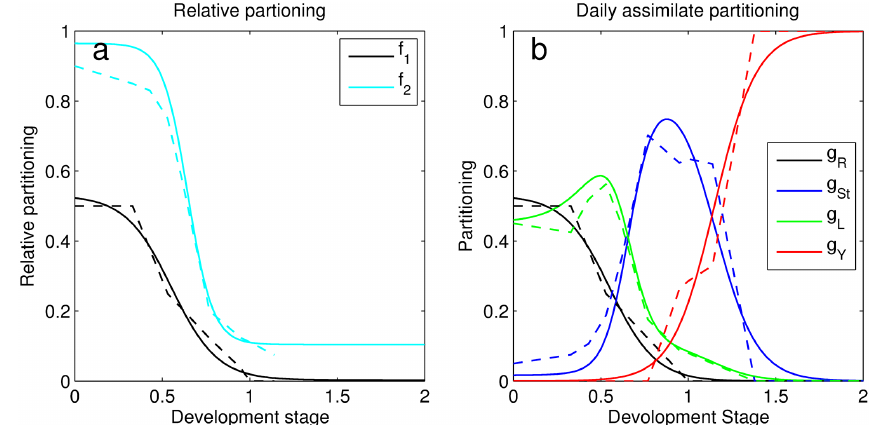
Figure 1. (a) The allocation to roots relative to vegetative organs ( f 1 ) and the allocation to leaves relative to leaves and stem ( f 2 ) for winter wheat. Dashed lines represent the allocation model from Penning de Vries et al. (1989) and solid lines are fitted Richards equations (Eqs. 3 and 4). (b) The resulting allocation scheme to roots ( g R ), stem ( g St ), leaves ( g L ) and grains ( g Y ) (solid lines) compared to data from Penning de Vries et al. (1989) (dashed lines) from equations in Eq.